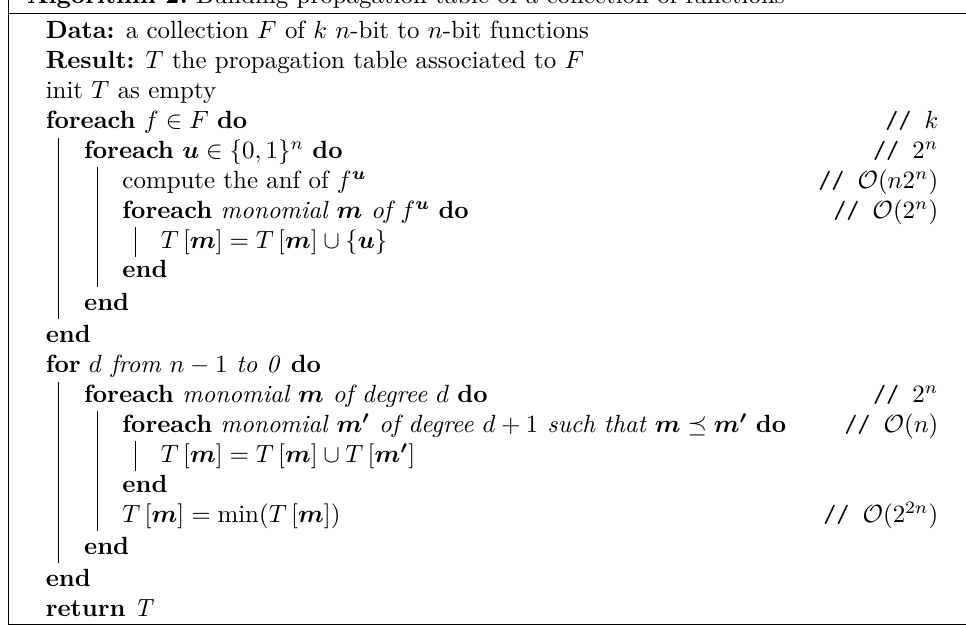
Algorithm 2: Building propagation table of a collection of functions Data: a collection F of k n -bit to n -bit